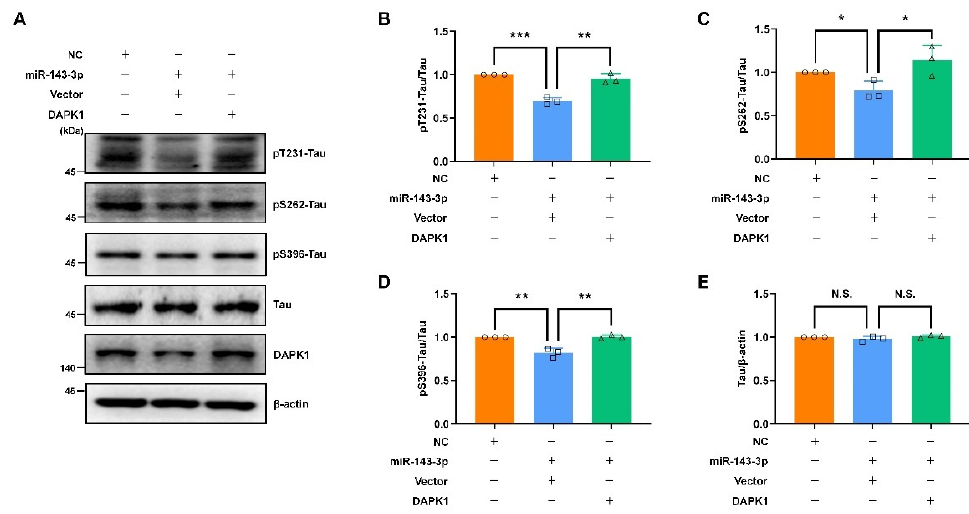
Figure 7. Restoring DAPK1 antagonizes the effects of miR-143-3p in decreasing tau phosphorylation. ( A ) SH-SY5Y cells were transfected with NC, miR-143-3p alone or miR-143-3p together with a plasmid encoding human DAPK1 for 48 h, and the levels of tau phosphorylated at Thr231, Ser262 and Ser396, total tau, and DAPK1 were analyzed by immunoblotting. ( B – E ) Relative quantification was performed using ImageJ software, and the results are presented as a histogram. The data (circles, squares and triangles) are presented as the mean ± SD of three independent experiments (* p < 0.05, ** p < 0.01, *** p < 0.001, N.S., not significant).